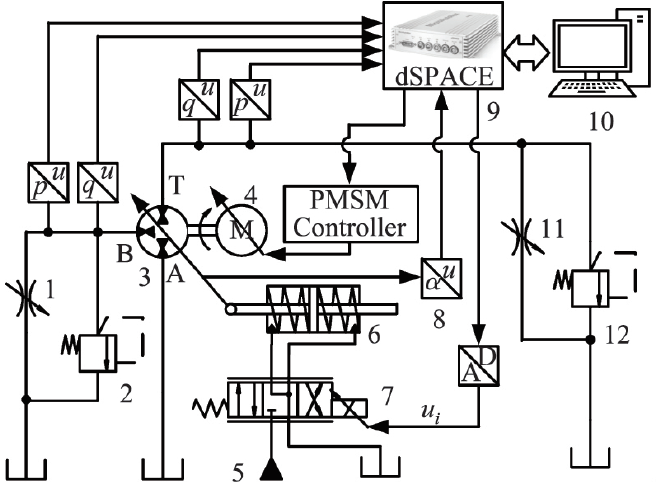
Figure 22. Axial piston pump test system.